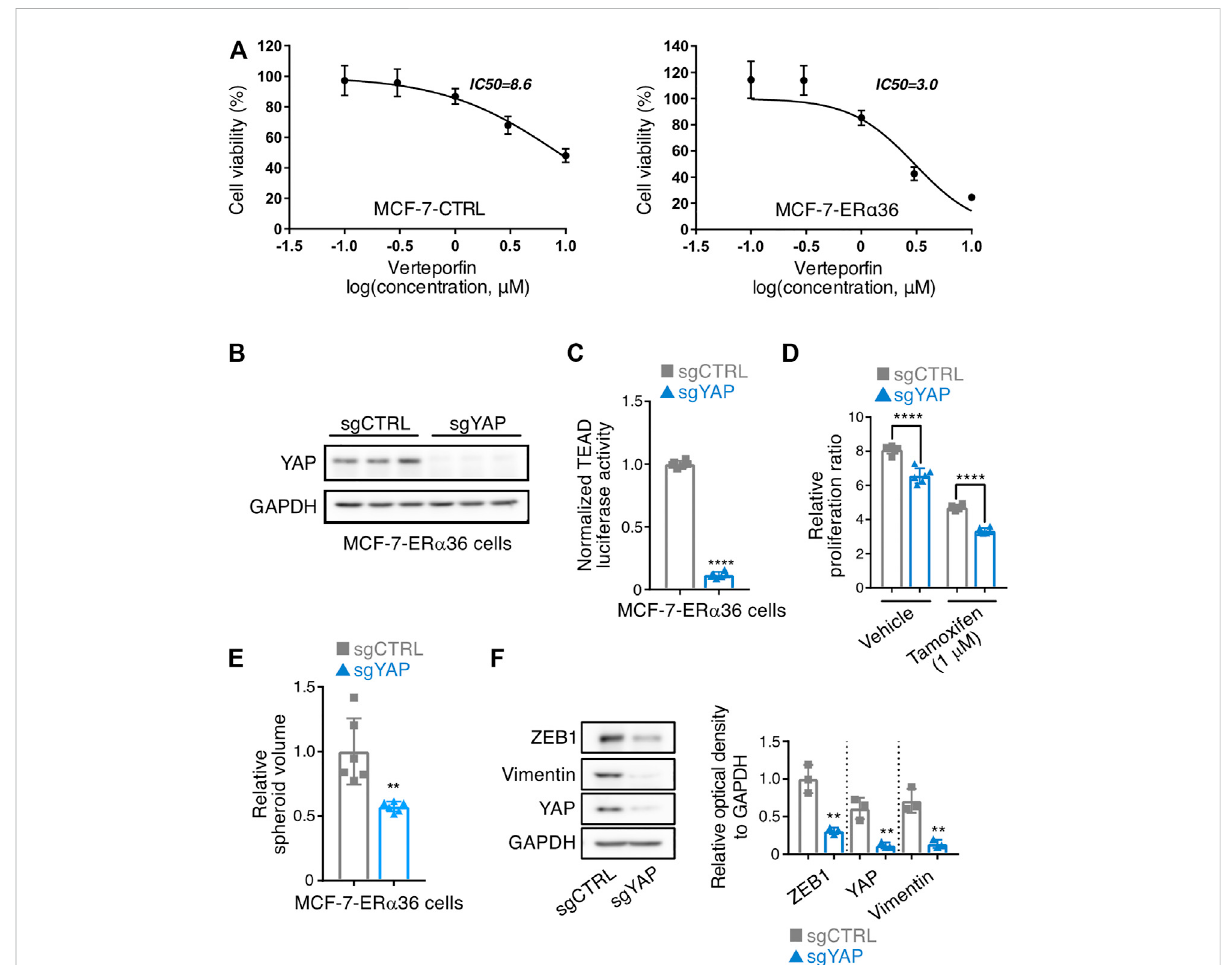
FIGURE 3 Inhibition of YAP reverses ER α 36-induced cell proliferation, 3D spheroid formation and EMT marker expression. (A) MTT analysis in MCF-7- CTRLandMCF-7-ER α 36cellsafterexposuretovertepor fi n(n=6). (B) SilencingofYAPbyCRISPR-Cas9-gRNA.ExpressionofYAPwasdeterminedby Western blot analysis to con fi rm its knockout. (C) YAP/TAZ-responsive TEAD reporter activities in the indicated cells. (D) Effect of YAP knockout on the cell proliferation and responsiveness to tamoxifen in MCF-7-ER α 36 cells. Cells were treated with tamoxifen for 102 h. (E) Inhibition of 3D spheroid formations estimated by using areal-time cell imaging system in the indicated cells. (F) Expression of EMT-related proteins in theindicated cells (left) and the relative optical density of them (right). All statistical signi fi cance of the differences was determined by unpaired two-tailed Student t test.**, p < 0.01; ****, p < 0.001 signi fi cant as compared with ER α 36sgCTRL cells. An abbreviation isas follows:sgCTRL, single guide RNAused asa negative